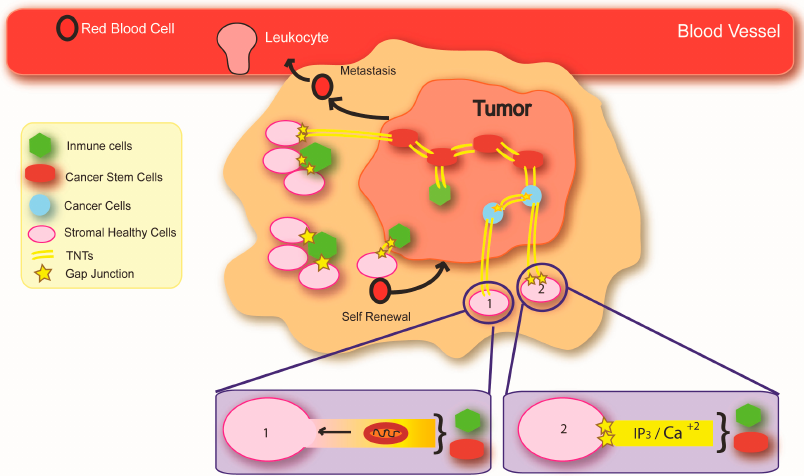
Figure 2. Representation of the potential role of gap junctions (GJs), hemichannels (HCs), and tunneling nanotubes (TNTs) in carcinogenesis. GJs and TNTs are expressed in a localized manner to help the tumor to invade neighboring tissues. Tumor cells (stem cells and cancer cells) communicate between them and surrounding cells (stromal healthy cells, immune cells) through TNTs and GJs, transferring organelles and metabolic agents from cancer stem cells and immune cells to stromal healthy cells. (1) An open-ended TNT allows the exchange of organelles (mitochondria), vesicles, and small molecules between the connected cells. (2) The open-ended TNT contains Cx protrusions that allow the exchange of small molecules, such as Ca 2+ or inositol triphosphate (IP 3 ), between connected cells.